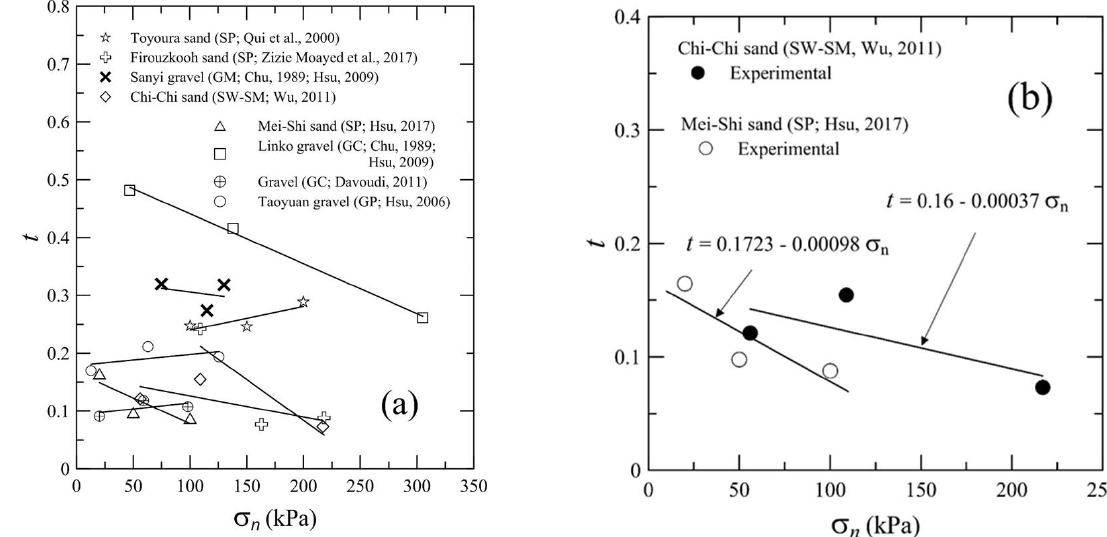
Figure 4. ( a ) Experimental and fitted lines for t vs. σ n relationship obtained in various studies; ( b ) Close-up of t vs. σ n relationship reported by Wu (2011) and Hsu (2017).